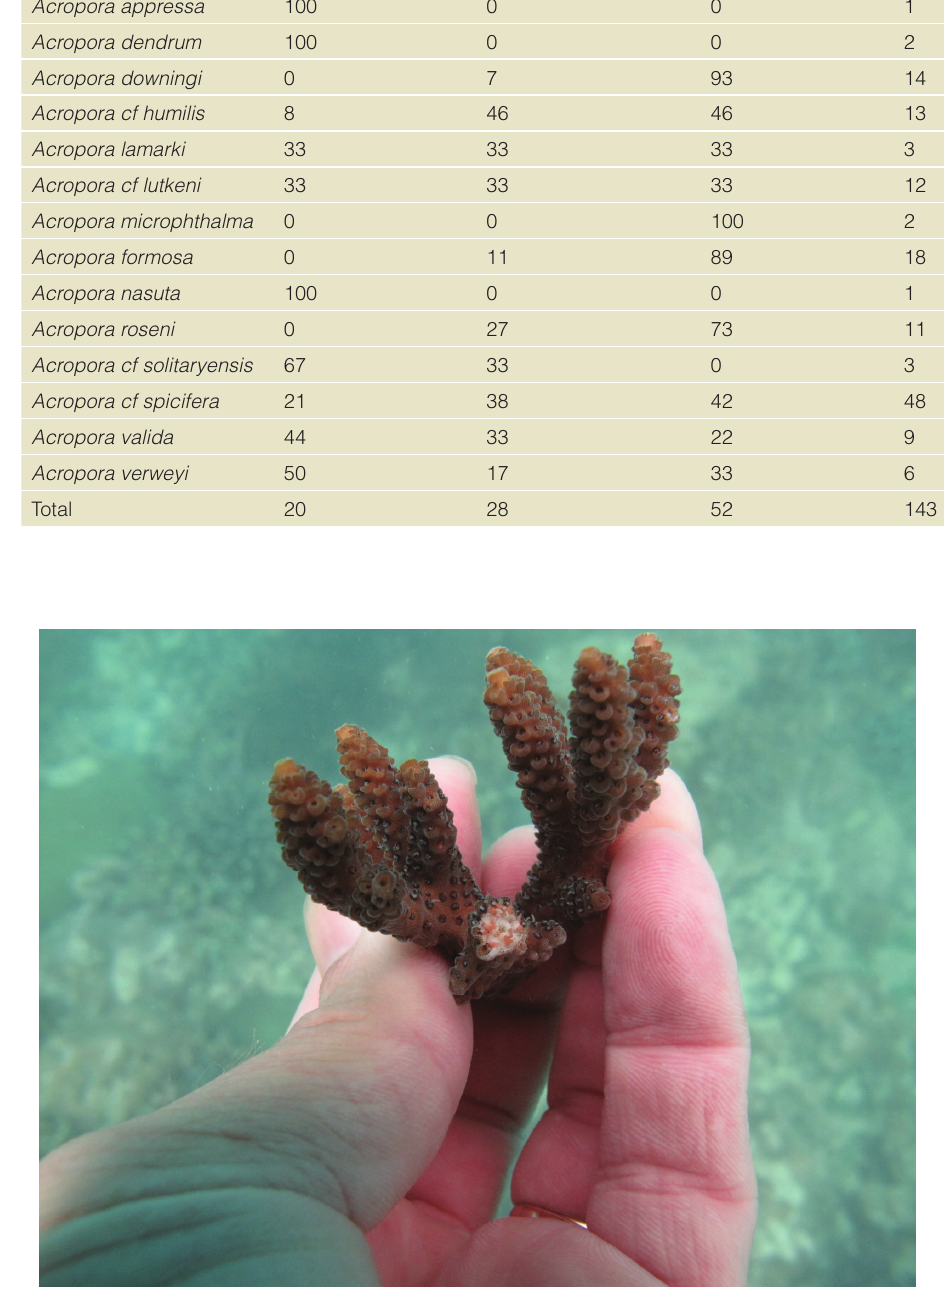
Figure 2. Mature (colored) oocytes are clearly visible in the branches of Acropora